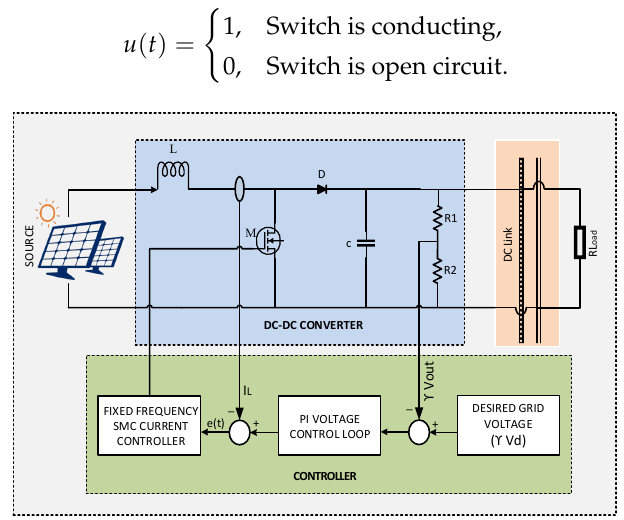
Figure 2. Simplified scheme for the voltage and current control using DC–DC boost